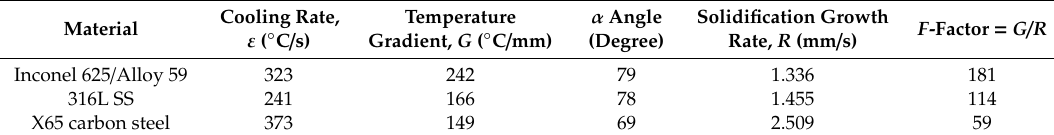
Table 4. Estimated solidification parameters at the liquid/solid interface, i.e., solidification front. Cooling rate is calculated for the temperature range from the peak temperature to solidus point.